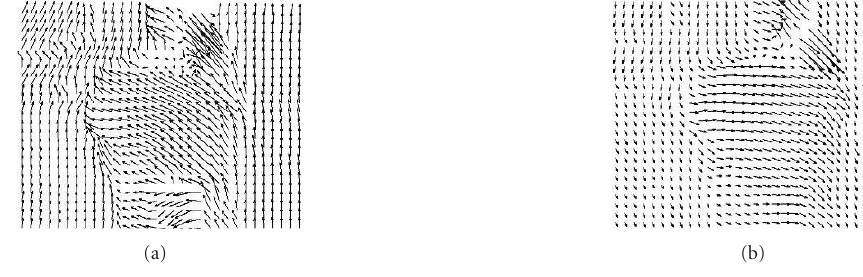
Figure 9: Motion estimates of frame 22 (a) and frame 25 (b) in the nonsynthetic “Foreman” experiment.